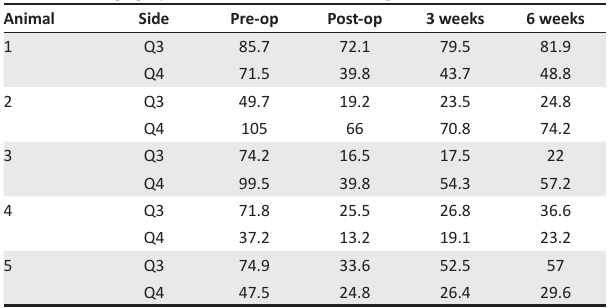
TABLE 3: Average grey scale values for the left and right mandibles of each animal. Animal Side Pre-op